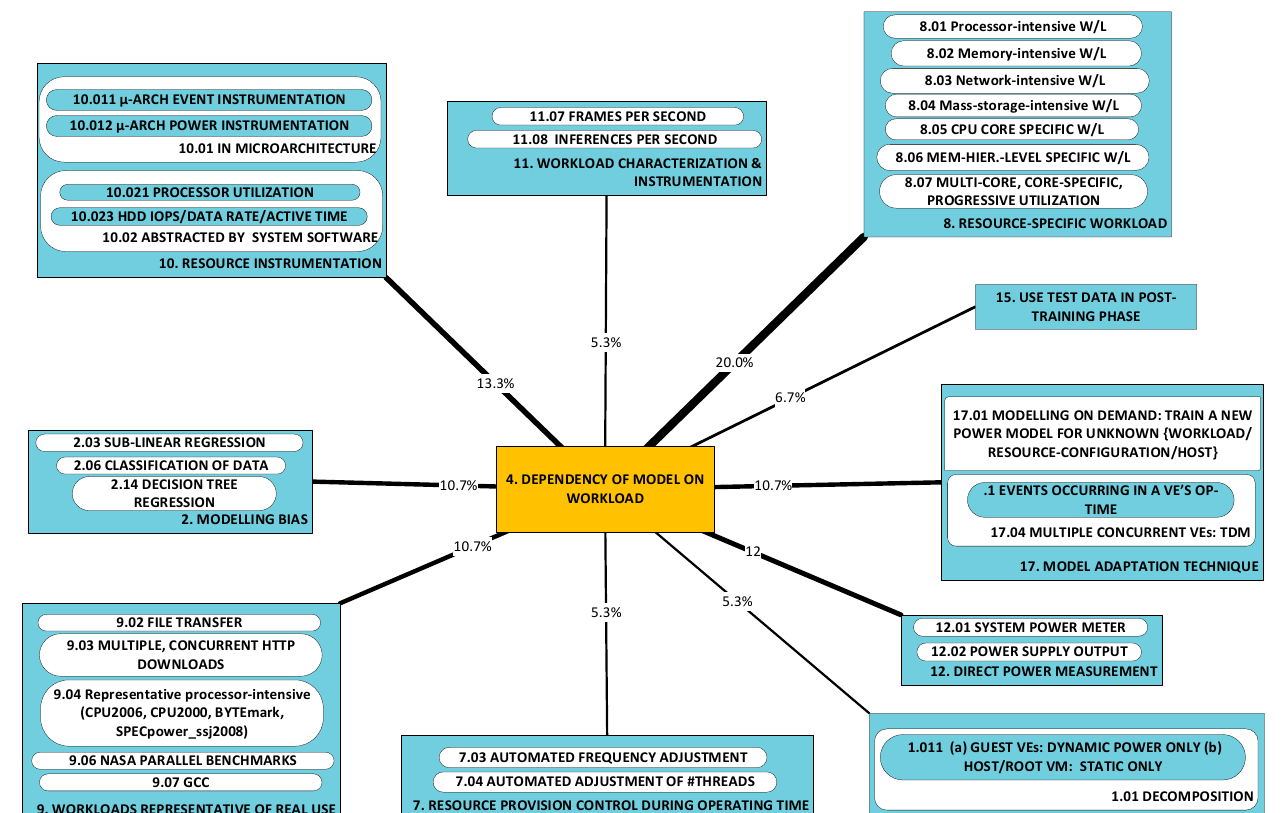
Figure 11. Approaches to solving challenges in category P4; utility metric U A ness and as a percentage. RUs in the respective categories are the following: P4 [56,62,67–69,71,75–79];